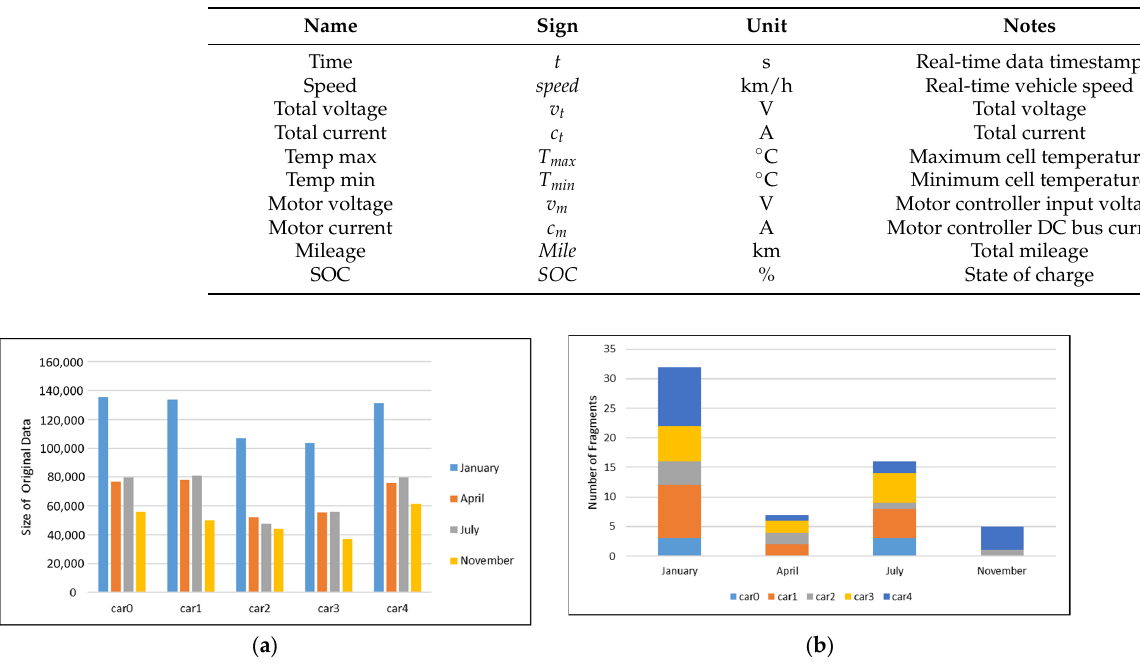
Figure 1. Original data size and number of fragments. ( a ) Distribution of the original data from different vehicles and different months; ( b ) fragmentation in according to SOC range from 100% to 25%, and distributed accordingly to vehicles and months.